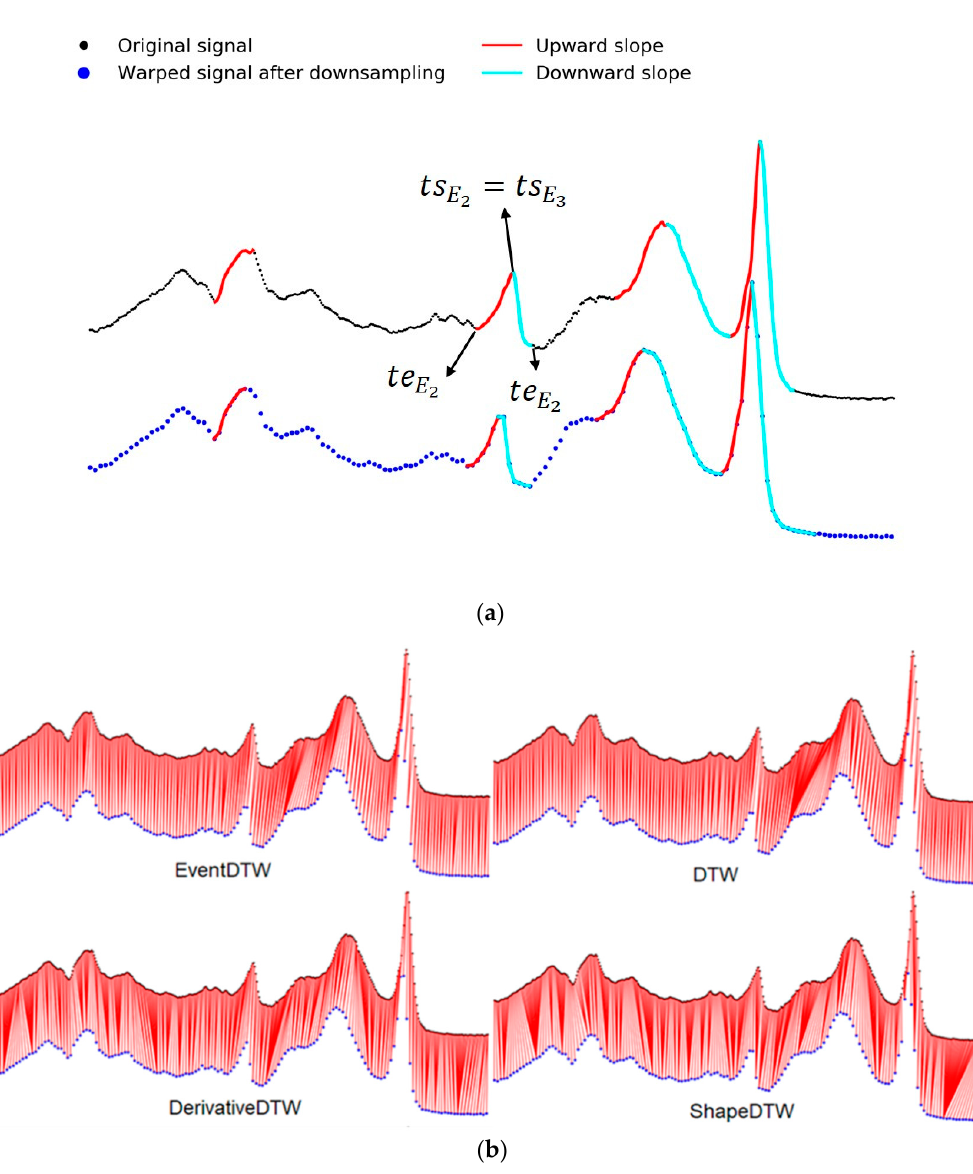
Figure 4. An example of application of four dynamic time warping (DTW) algorithms to the BEEF signal from UCR dataset [20] in which EventDTW (eDTW) outperforms DTW, derivative DTW (dDTW), and shape DTW (sDTW). ( a ) The event information propagation process, and ( b ) the alignment after applying four methods to the signals in ( a ).